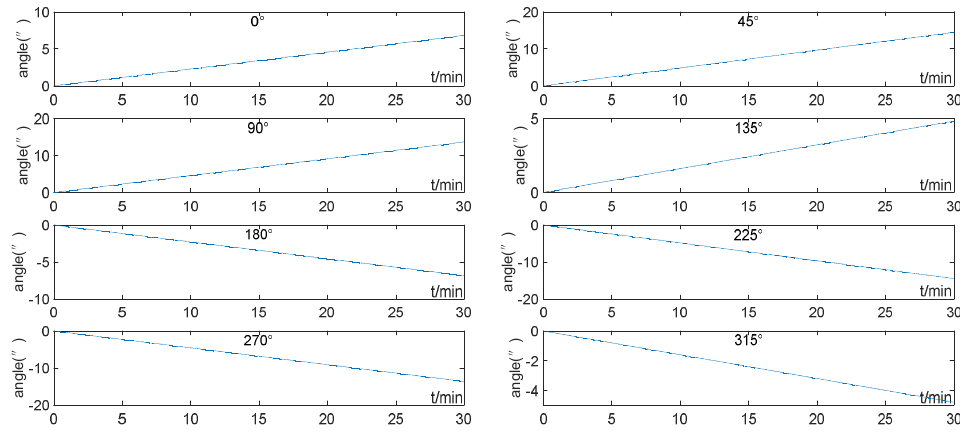
Figure 3. Heading error of 8-orientation simulation test on static base.